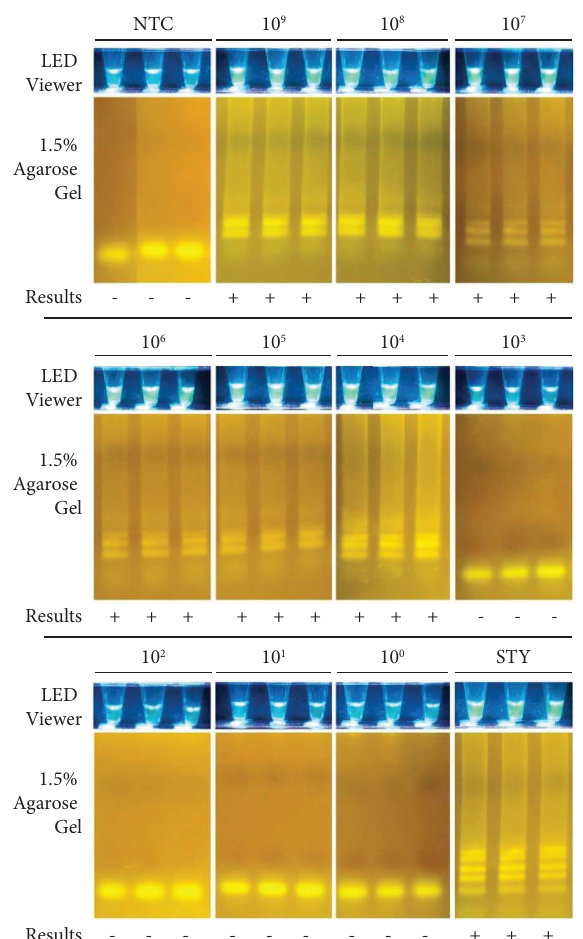
Figure 9: Assay sensitivity. Sample (2.5 μ L) was added to 10 µ L reagent mix then incubated at 65 ° C for 60 minutes, 80 ° C for 2 minutes, and cooled to 4 ° C for 10 minutes using T100 Termal Cycler (S/N 621BR14432; Bio-Rad Laboratories, Inc., CA, USA). Samples used were the No Template Control (NTC), Salmonella enterica subsp. enterica sv. Typhi DNA (STY), and Positive Control (PC). Te following